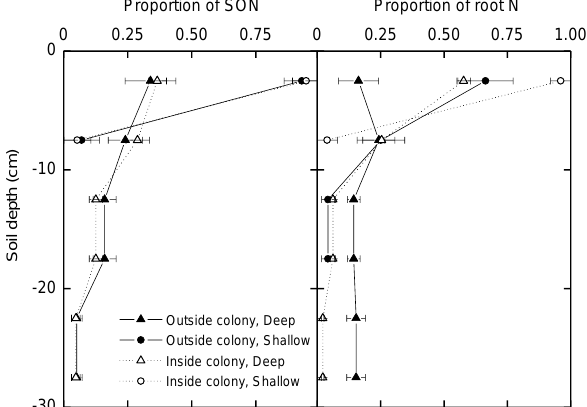
Figure 4. Mean ( ± SE) values of the N accumulation rate in four ecosystem types on Surtsey. The inserted graph gives values outside the colony in more detail. White bars show the average N accumulation values between 1963 and the sampling year (2012 or 2013). Black bars show the N accumulation after the start of seagull colonization. Statistical results are shown in Table